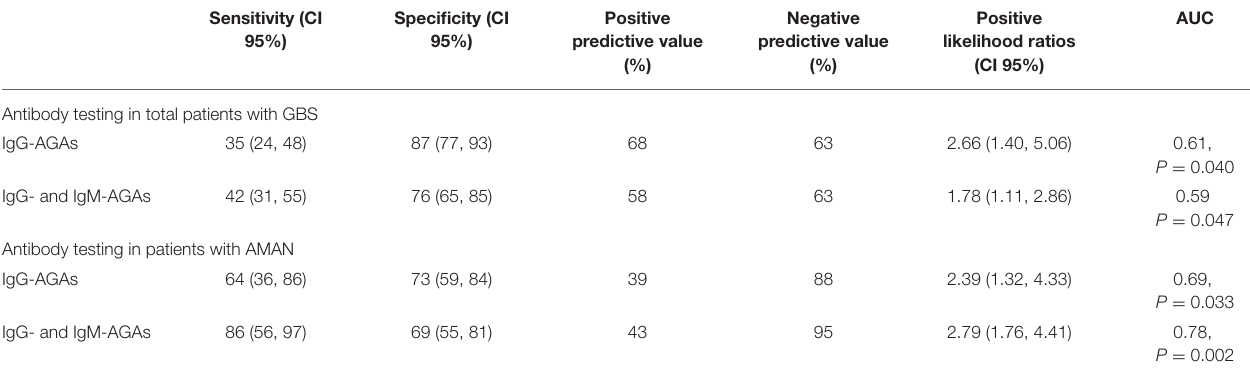
TABLE 1 | Antibody testing results.